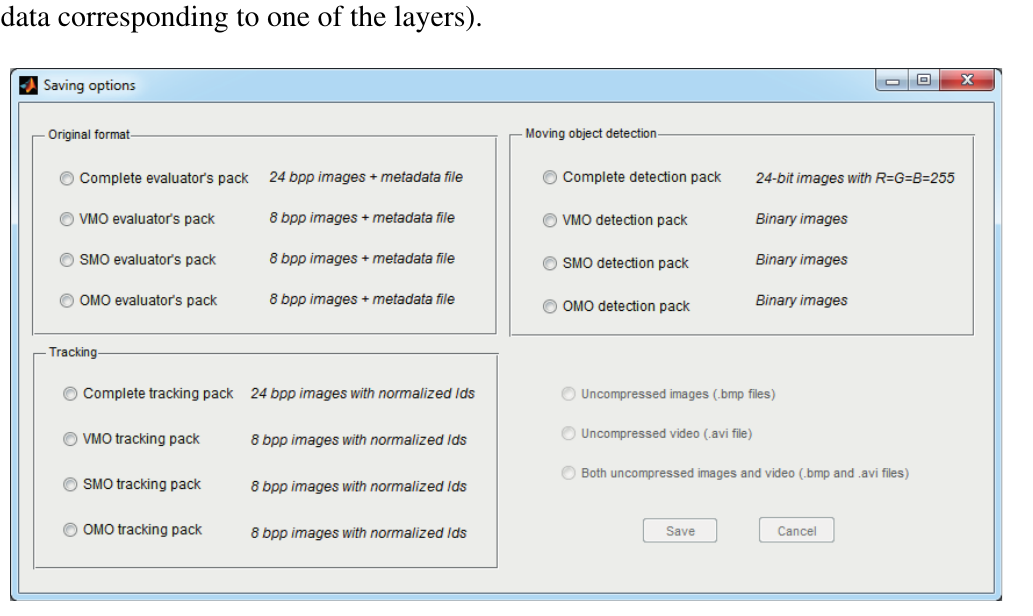
Figure 10. Saving options included in